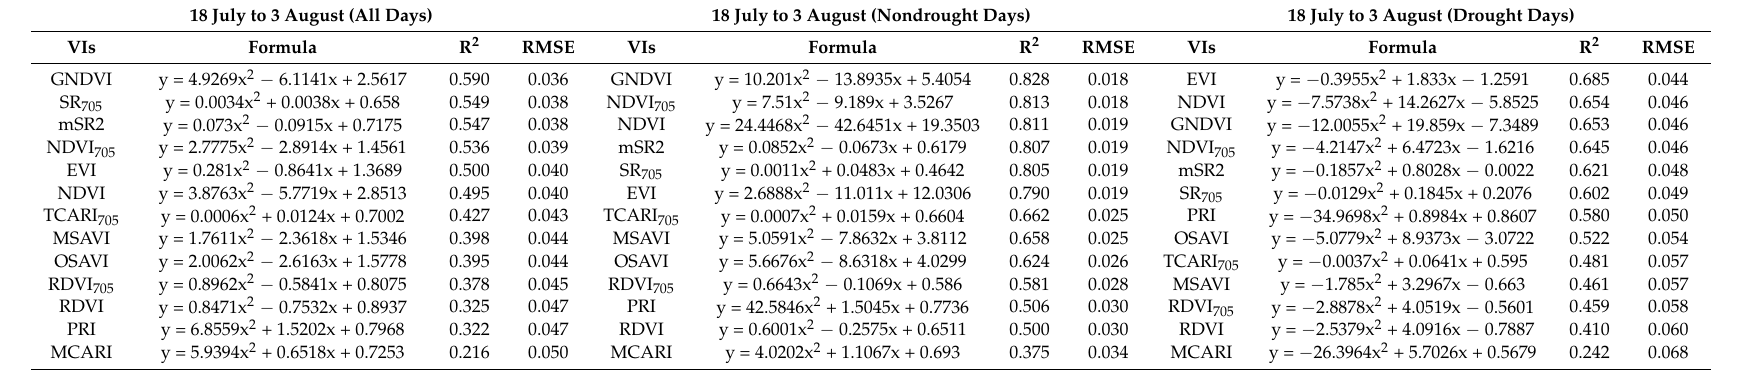
Table 5. Regression equations between the FPAR (y) and VIs (x) for three different kinds of